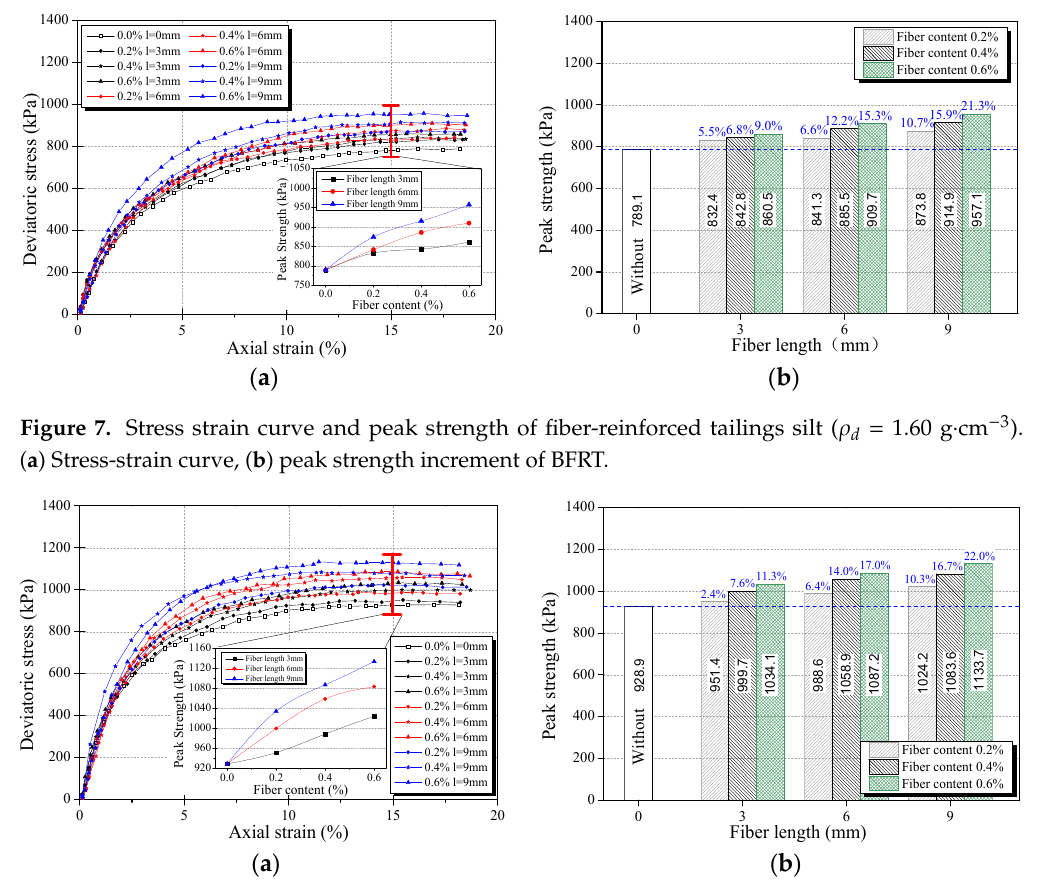
Figure 6. Stress strain curve and peak strength of fiber-reinforced tailings clay ( ρ d = 1.52 g·cm − 3 ). ( a ) Stress-strain curve, ( b ) peak strength increment of BFRT.